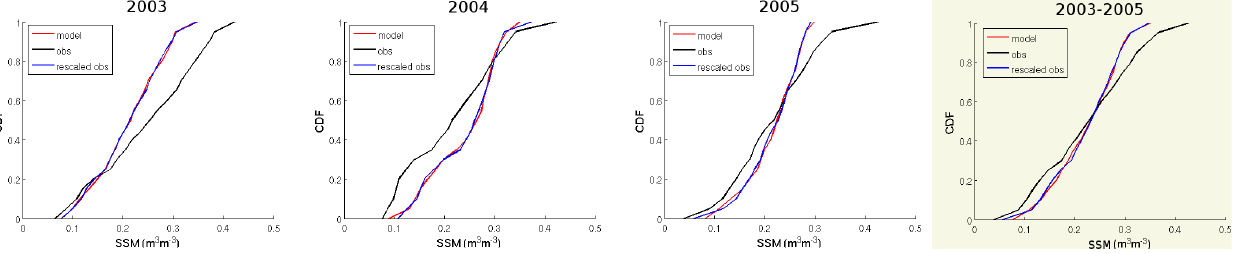
Fig. 12. CDF matching between w 1 modeled with ISBA-DF LSM and SSM observations for 2003, 2004, 2005 and the 3yr period. Fig. 12. CDF-matching between w modeled with ISBA-DF LSM and SSM observations for 2003, 1 Over the 3 yr period, the correlation coefficient, RMSE, 2004, 2005 and the 3-yr period. SDD and bias values of the w tot analysis are 0.90, 0.052, 0.052 and − 0.006 m 3 m − 3 , respectively. A slight increase of the statistical scores is noted with respect to DF-REF (Fig.